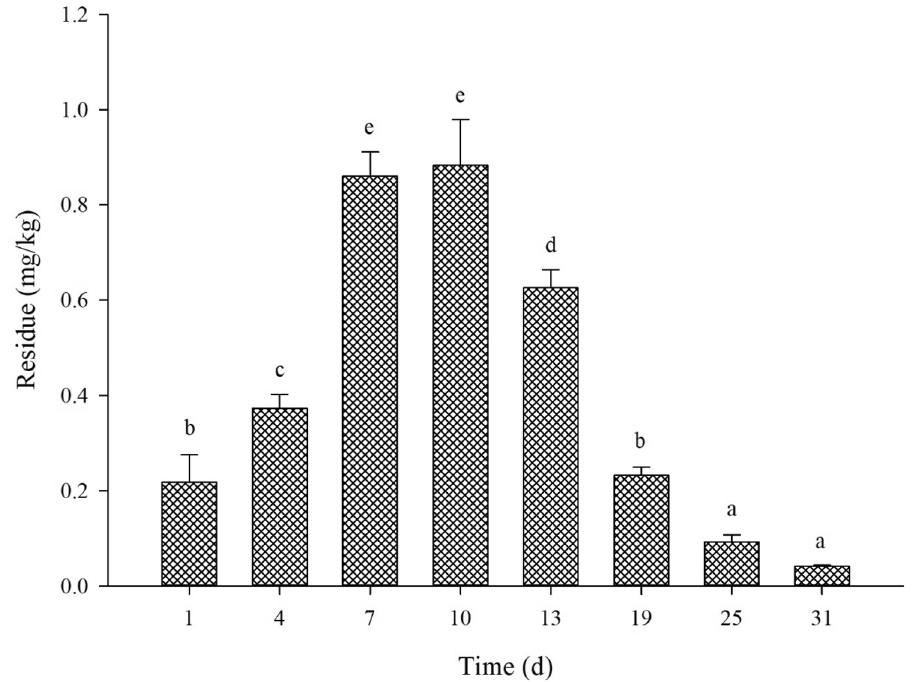
Figure 4. The degradation dynamics of spinetoram in the soil. The Y-axis represents the spinetoram residual amount and the X-axis represents the number of days post-treatment. Alphabets (a–d) indicate the statistical significance at P ≤ 0.05.